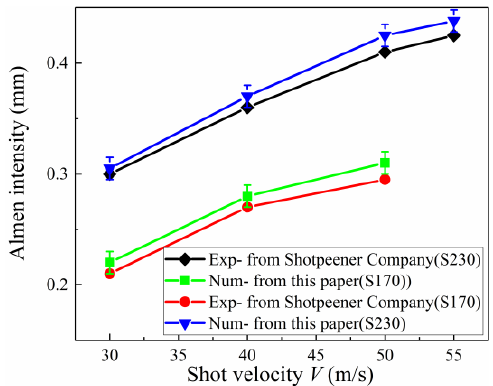
Figure 16. Numerical and experimental relationships between Almen intensity and shot velocity for two shot sizes and impingement angle θ = 90°.